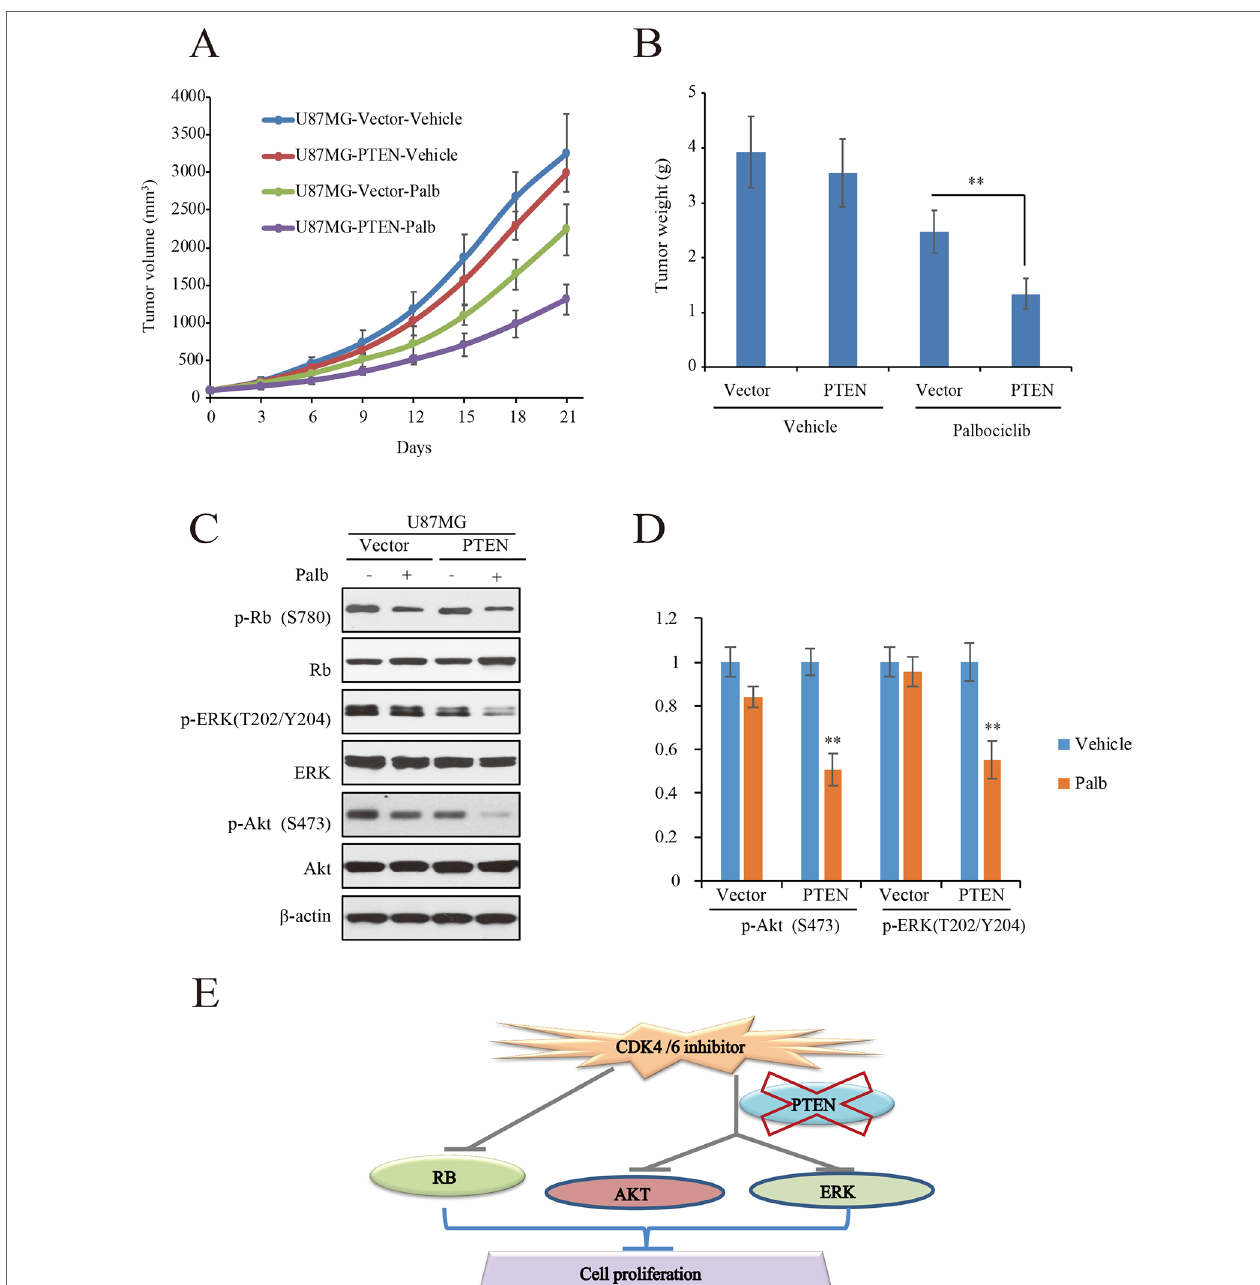
FIGURE 6 | Palbociclib selectively blocks PTEN-expressed U87MG cells in vivo . (a , B) U87MG isogenic cells were inoculated subcutaneously; mice were treated with palbociclib as described in Materials and Methods . Tumor volumes (a) and tumor weight (B) were examined throughout the experiment. Data are shown as mean ± SD (* P 0.05, ** P 0.01, t -test, eight mice/group). (C) Effects of palbociclib on the levels of p-ERK, p-Akt, as well as p-Rb in U87MG-Vector/PTEN tumors. Following treatment, tumor tissues were collected. The lysates were analyzed by western blot assay with indicated antibodies. (D) Quantification of the blots in (C) . Data are shown as mean ± SD (** P 0.01, vs. vehicle treatment, t -test, n = 3). (E) A schematic diagram shows the role of PTEN in CDK4/6 inhibitor-induced inhibition of GBM cells.